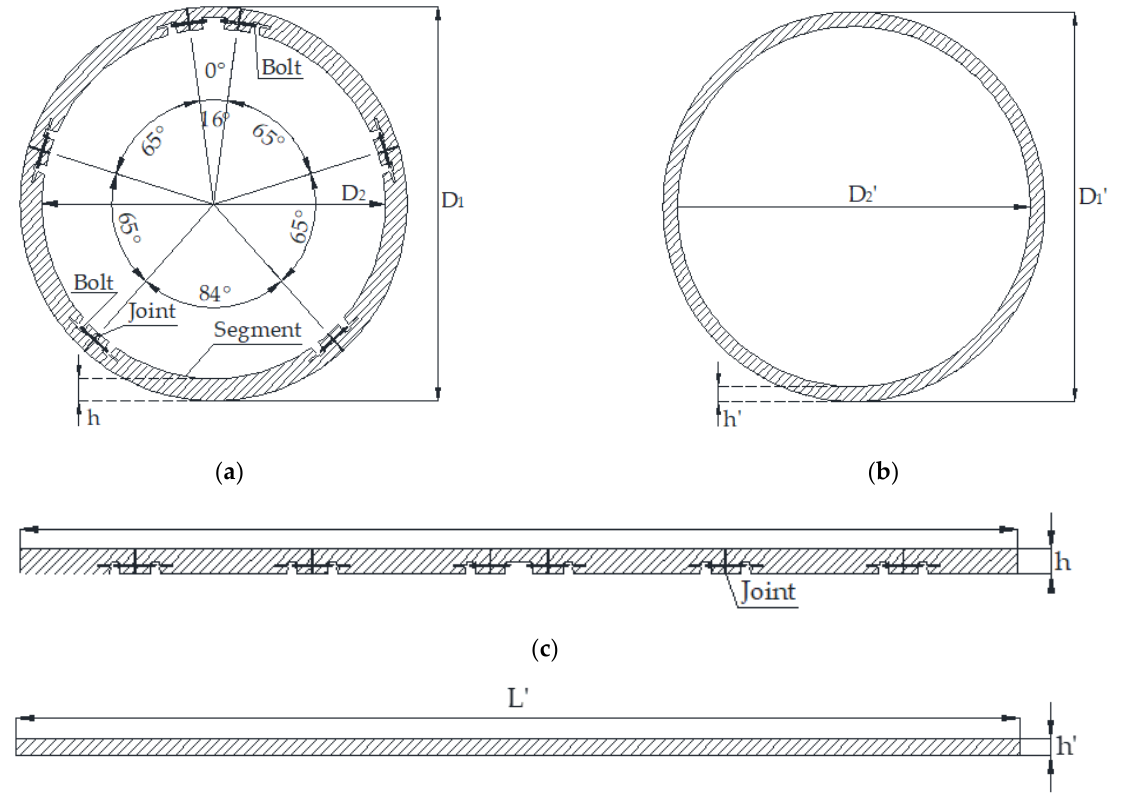
Figure 1. Straight beams spread from the installed segment ring and the modified uniform rigidity ring: ( a ) Installed segment ring; ( b ) modified uniform rigidity ring; ( c ) straight beam spread from the installed segment ring; ( d ) straight beam spread from the modified uniform rigidity ring.